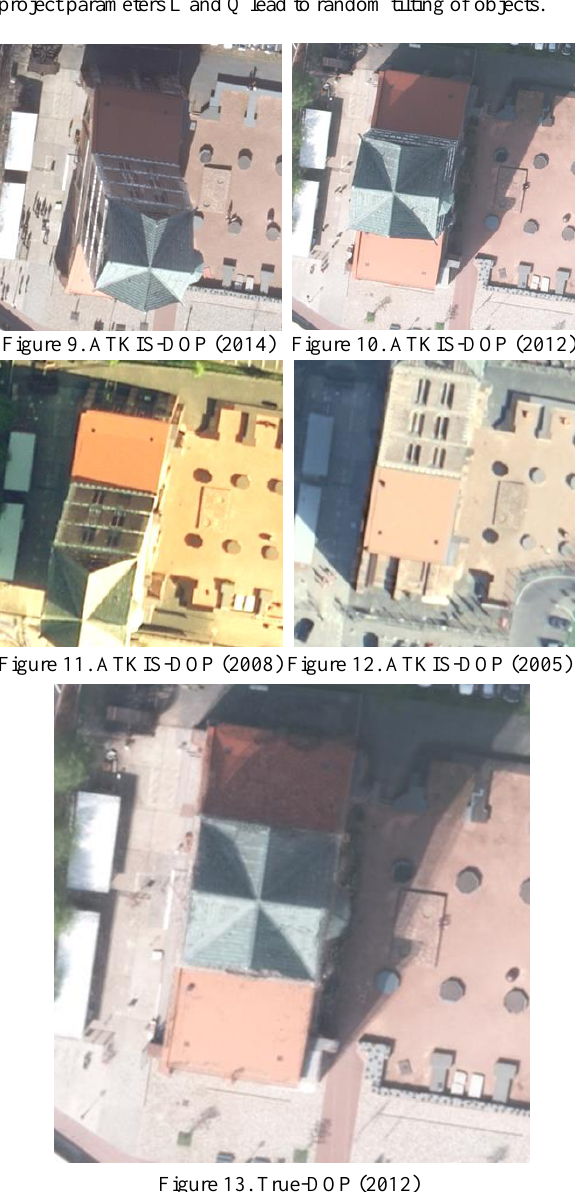
Figure 13. True-DOP (2012)